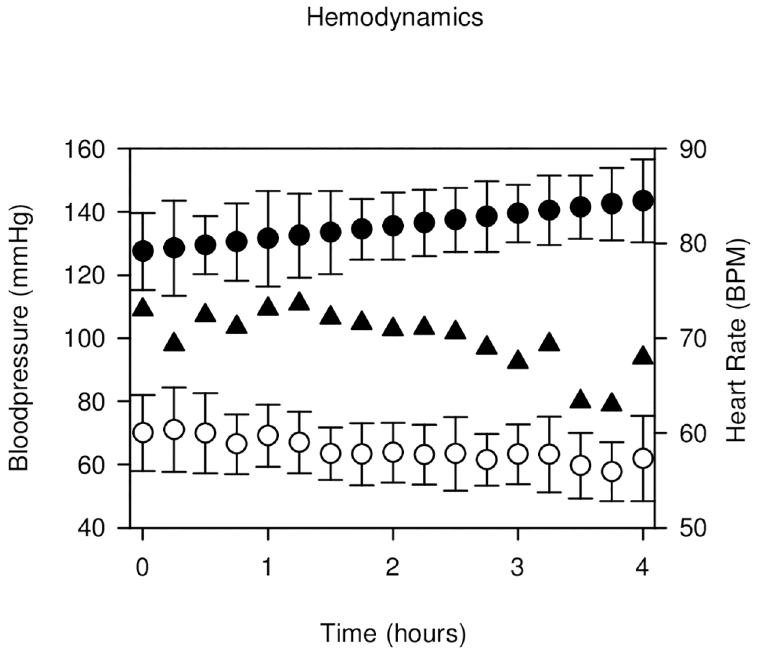
Fig 3. Hemodynamics. Duringthe first four hours of the trial. (cid:14) Systolic blood pressure (mean and SD)). ● Diastolic blood pressure (mean and SD)). Heart Rate (BPM, mean)) ▲ .